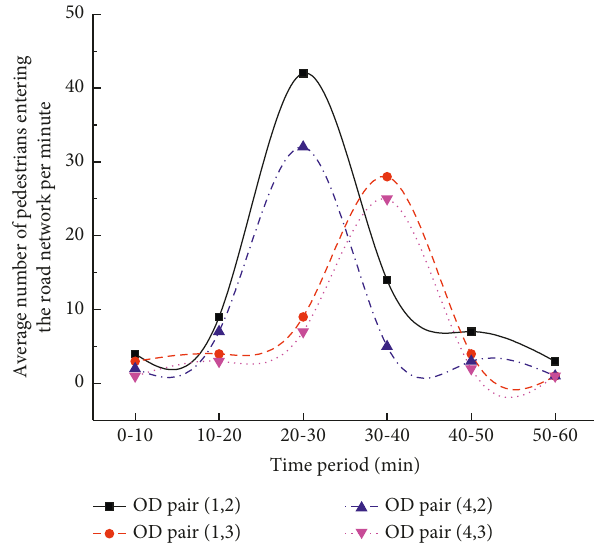
Figure 7: The ingress rules of passenger flow between different OD